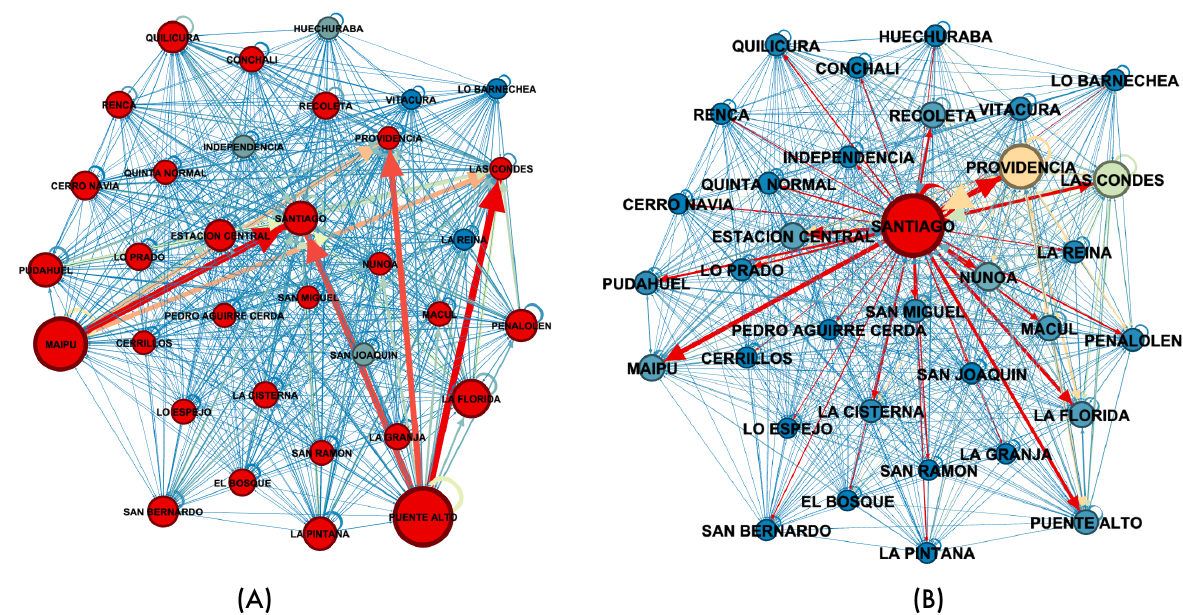
Figure 8. Origin–destination between communes of Santiago City ( A ) at 6:00 a.m. and ( B ) at 6:00 p.m. on a regular pre-pandemic weekday. The sizes of the arrows are related to the number of trips, and the sizes of the nodes with its